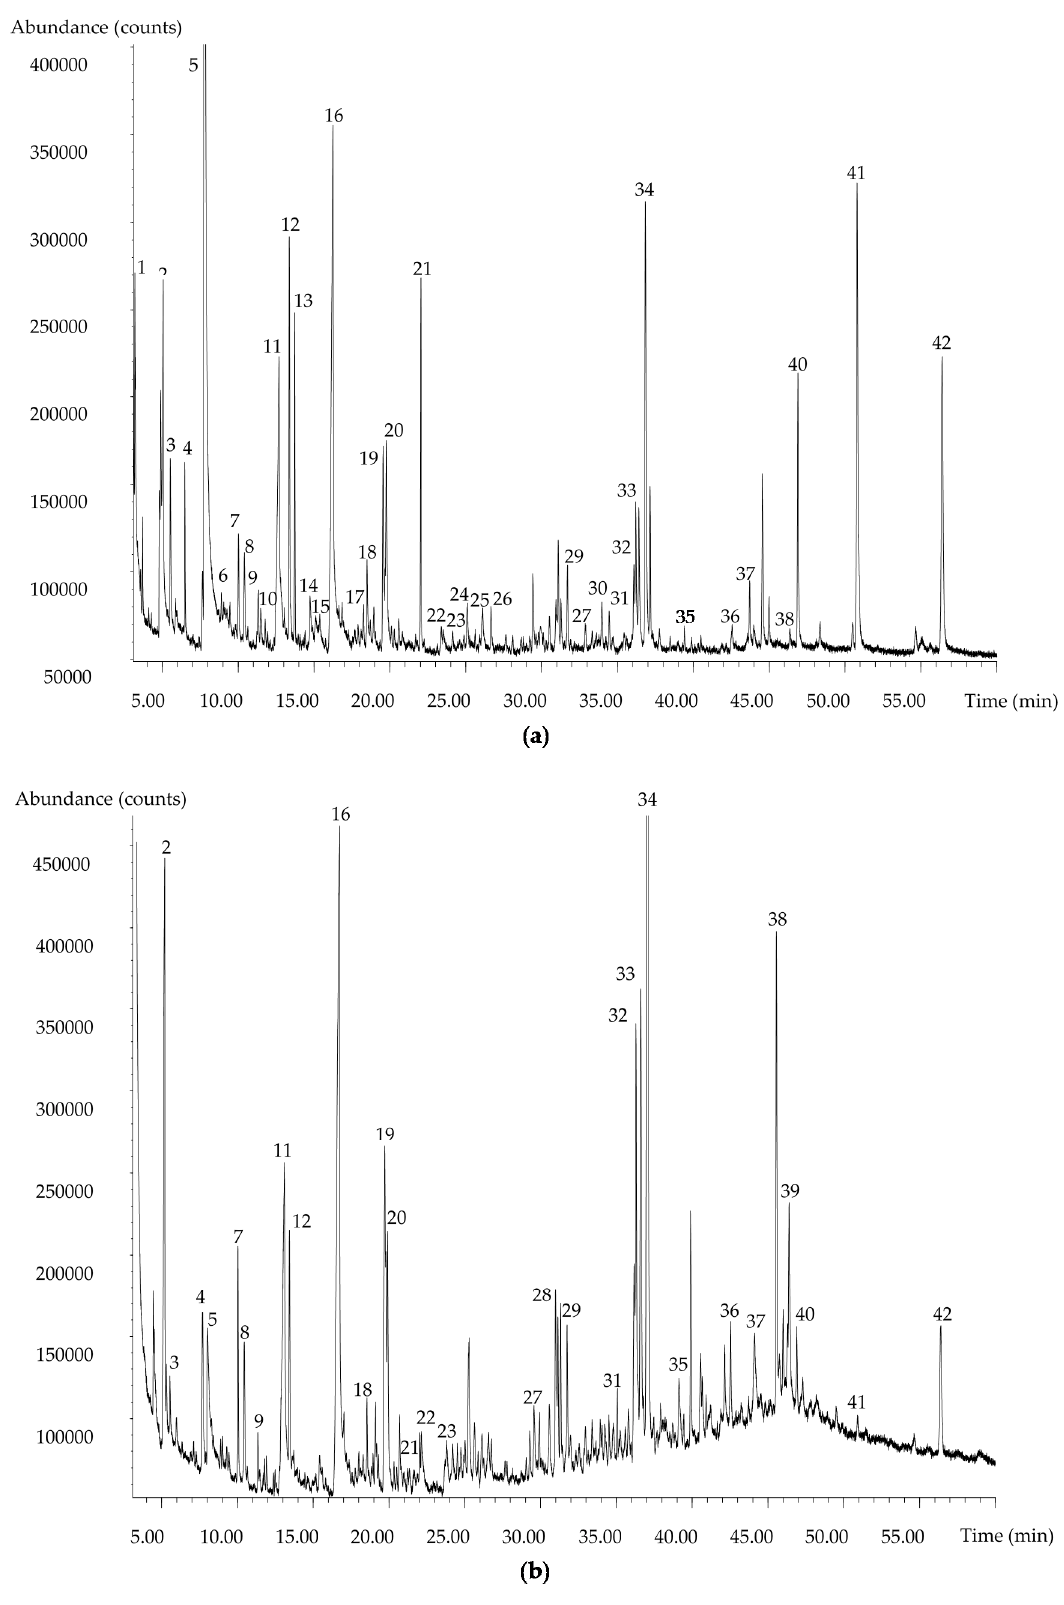
Figure 1. Comparison of representative total ion chromatograms of apple honey volatiles extracts obtained using the proposed DHLLE method ( a ) and the USE extraction with CH 2 Cl 2 ( b ). The numbers correspond to the compounds listed in Table 2.